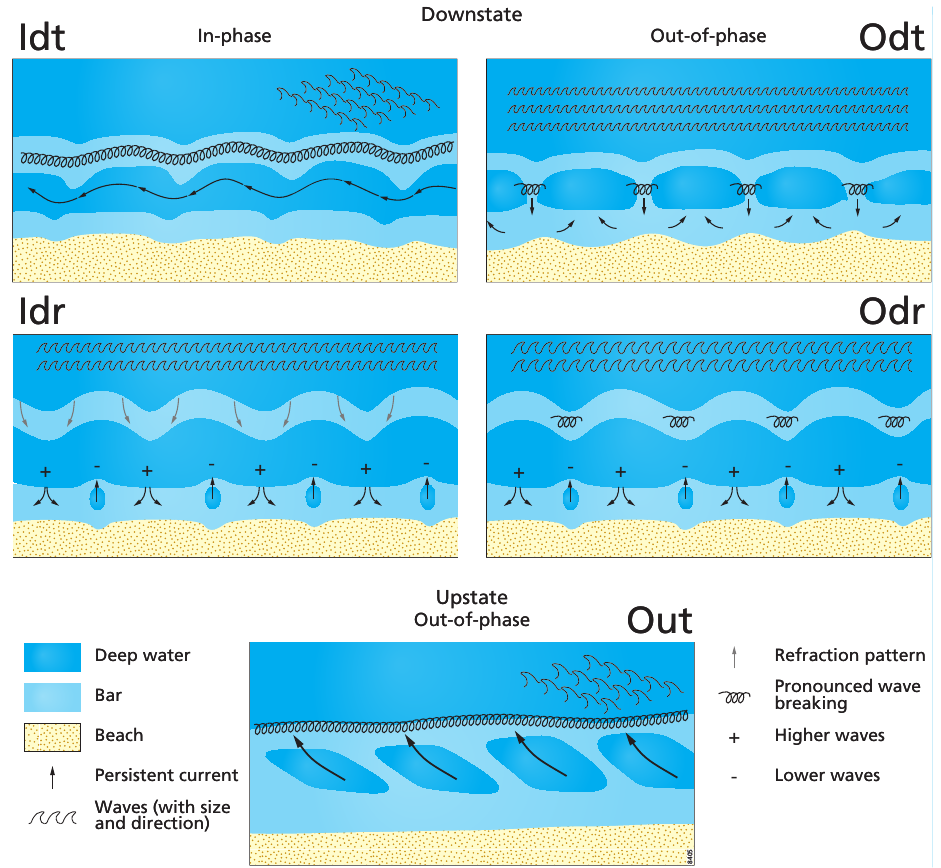
Figure 8. Conceptual model of the development of different coupling